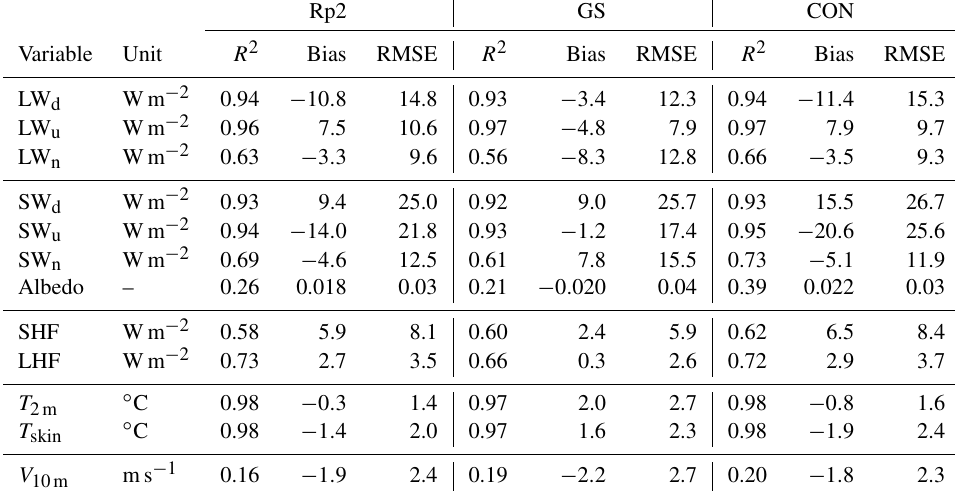
Table 2. Statistics of the monthly-averaged downward, upward, and net longwave and shortwave fluxes during summer (LW d , LW u , LW n , SW d , SW u , SW n , respectively), albedo, sensible heat flux (SHF), latent heat flux (LHF), 2m temperature ( T 2m ), skin temperature ( T skin ), and 10m wind speed ( V 10m ) using AWS data of DML between 1997 and 2012 (locations shown in Fig. 2b). We use the ratio of the monthly sum of SW u and SW d to determine the albedo. For all variables, 202 observations are available. The correlation coefficient ( R 2 ), bias and root-mean-square error (RMSE) are shown for Rp2, GS and CON. In all following figures, Rp2 is in black, GS in red and CON is in blue. Rp2 GS CON Variable Unit R 2 Bias RMSE